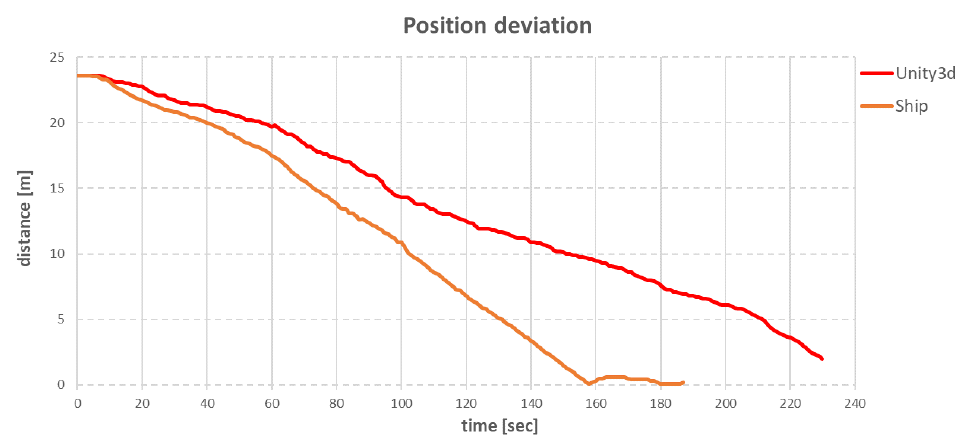
Figure 33. Comparison of the ship ’ s position deviation after changing target position, between the real ship and the virtual ship.